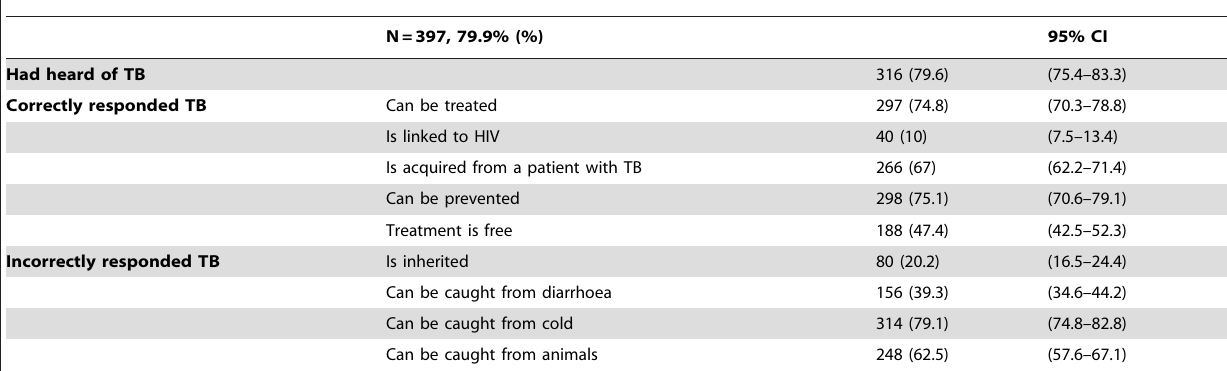
Table 2. Knowledge of TB among new patients (Questionnaire 1).